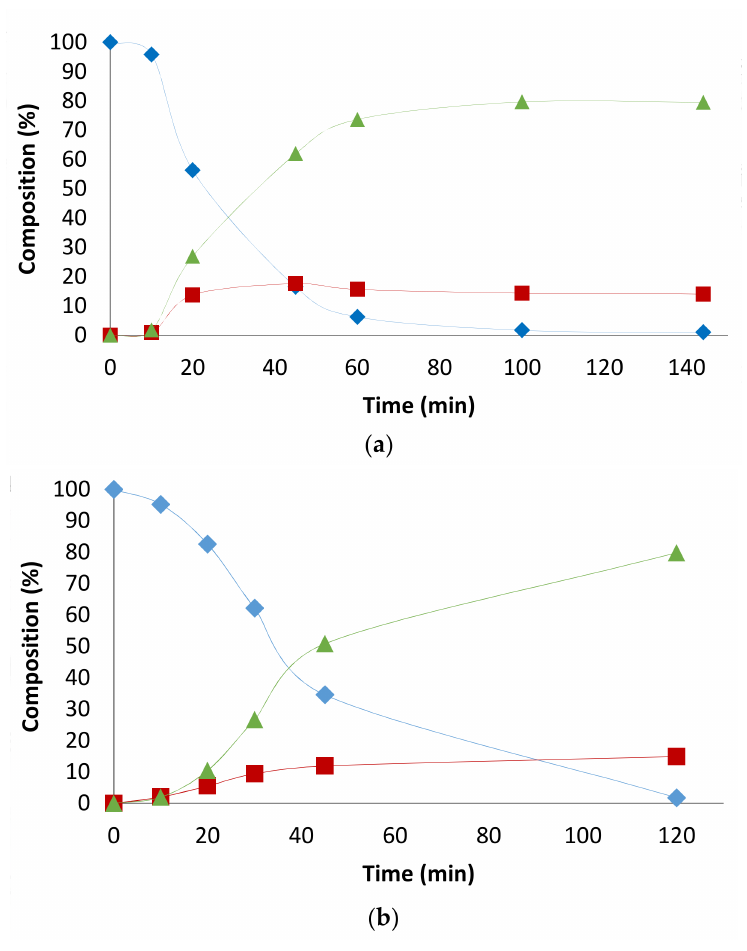
Figure A9. Composition profiles at [substrate] 0 /[Rh] = 3000 with methyl 10-undecenoate: ( a ) toluene; ( b ) acetonitrile ( (cid:7) 1 Me , (cid:4) 1 Me - int -x , (cid:78) 2 Me + 3 Me ) (conditions : 1 Me = 3.15 mmol, [ 1 Me ] 0 = 0.4 M,